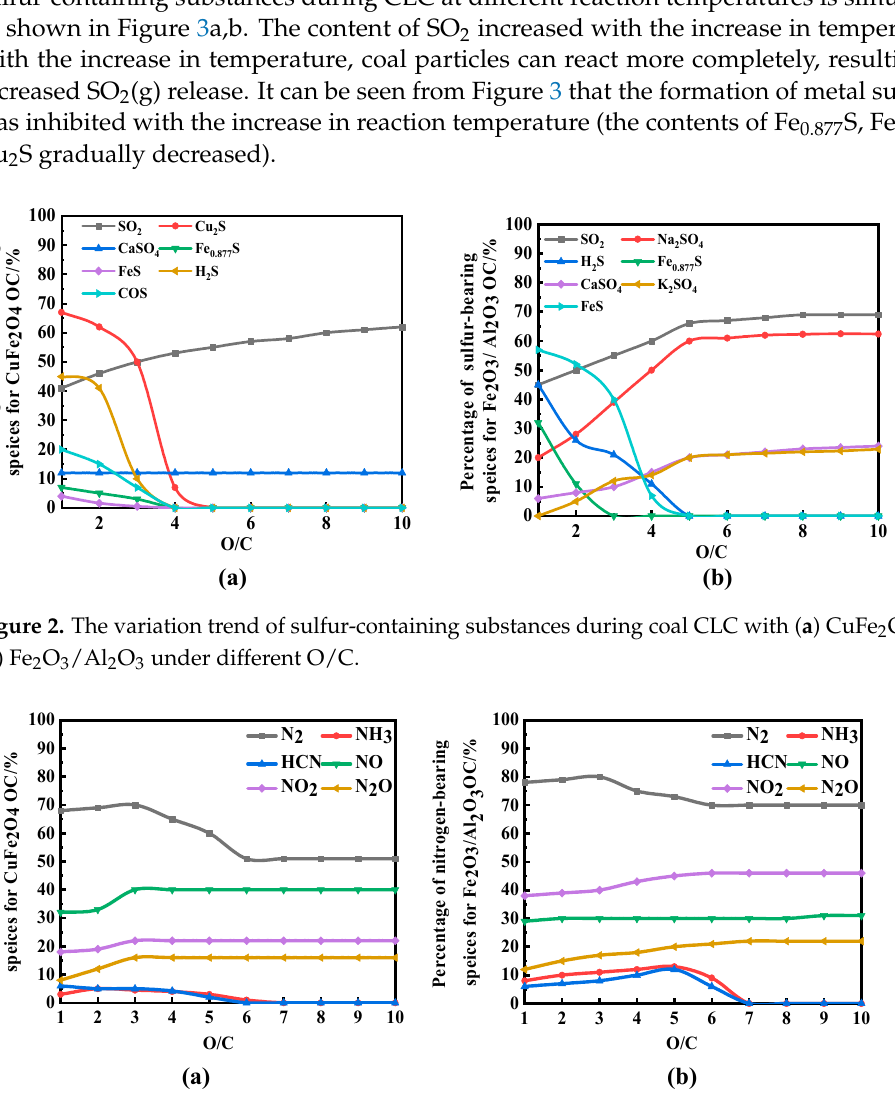
Figure 3. The variation trend of nitrogen-containing substances during coal CLC with ( a ) CuFe 2 O 4 and ( b ) Fe 2 O 3 /Al 2 O 3 with different O/C .